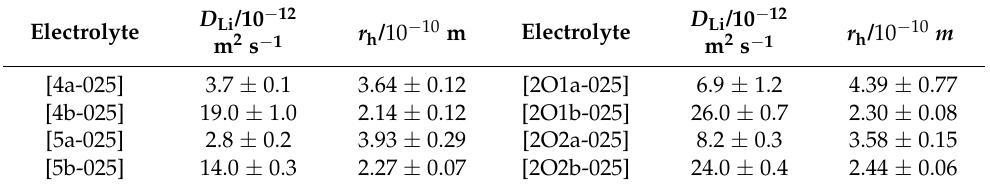
Table 6. Lithium self-diffusion coefficients for conducting salt-containing binary mixtures at 298 K. Electrolyte